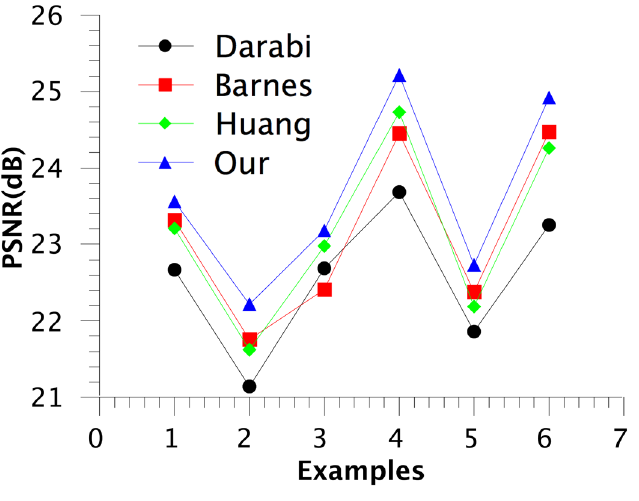
Fig 8. PSNR comparison.